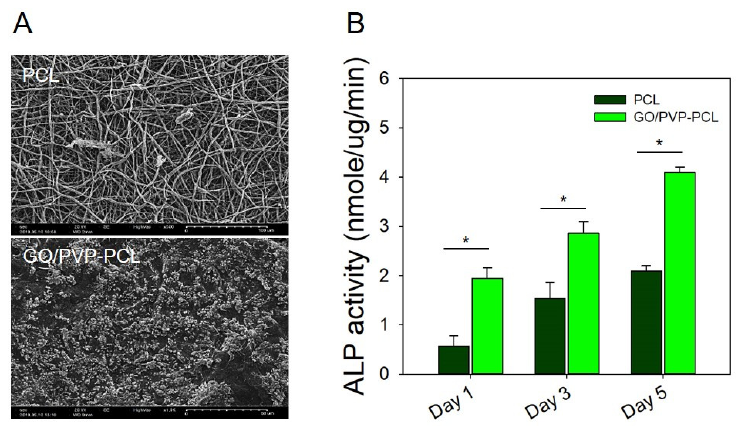
Figure 7. ( A ) SEM images (magnification of × 500 (100 µ m) and × 1000 (50 µ m)) of the mineralization using 1X SBF solution, ( B ) ALP activity of PCL and GO/PVP-PCL. “*” Indicates statistical significance relative to the PCL ( p < 0.05).